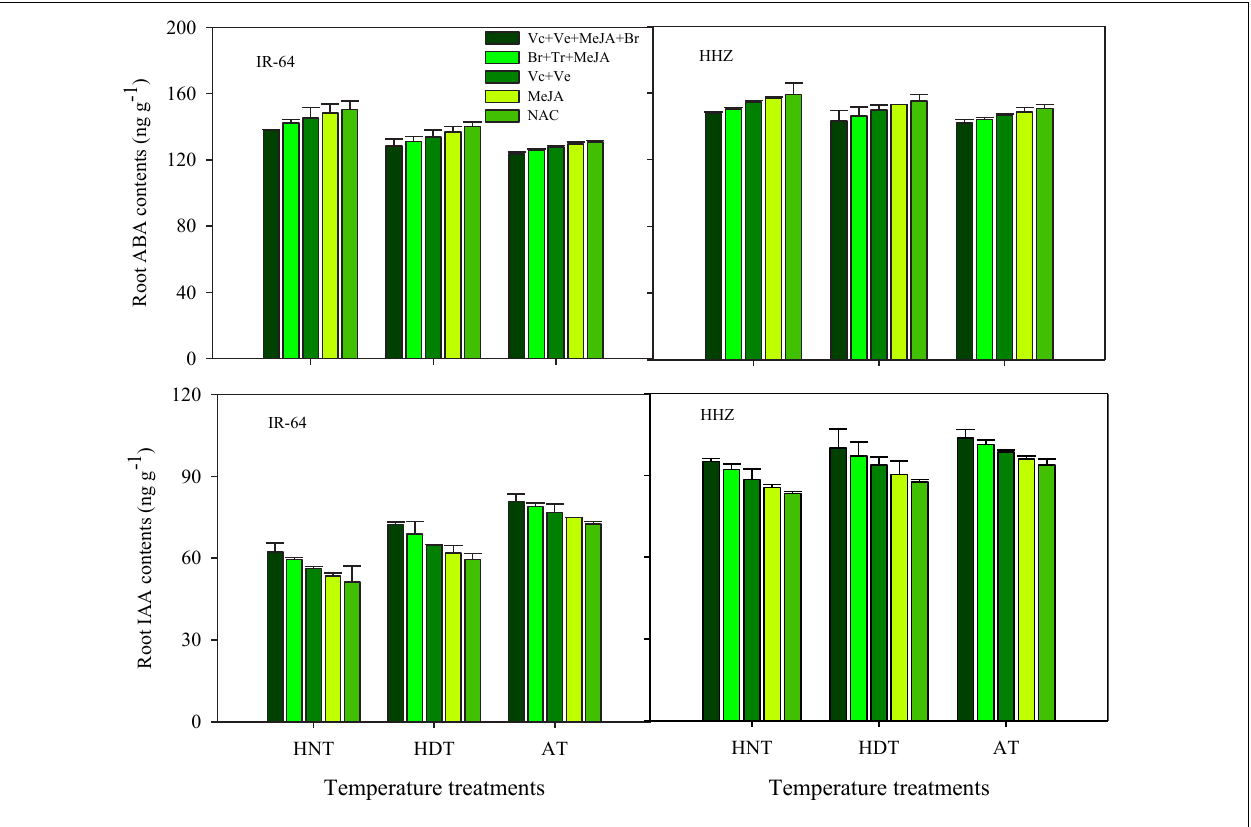
FIGURE 8 | Impact of PGRs on the concentration of abscisic acid (ABA) and indole-acetic acid (IAA) in rice